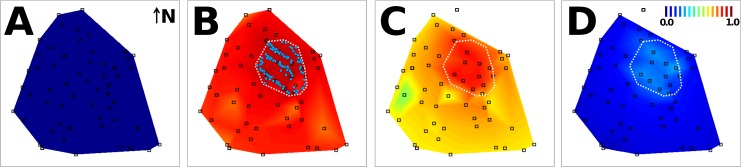
Mosquitoes effectively disseminated insecticide particles at the neighborhood scale.The contour plots are a spatial representation of the (period-specific) probability that at least one sentinel breeding site in a surveillance dwelling had evidence of contamination with mosquito-disseminated pyriproxyfen, as predicted by the generalized linear model in Table 2: A, before; B, during; C, early after; and D, late after the trial. The intervention sub-area is outlined in white in panels B (with pyriproxyfen dissemination stations represented by blue dots) to D. The scale in panel D shows the color code of probabilities. Surveillance dwellings are represented by squares; note that surveillance was discontinued in the northernmost dwelling.